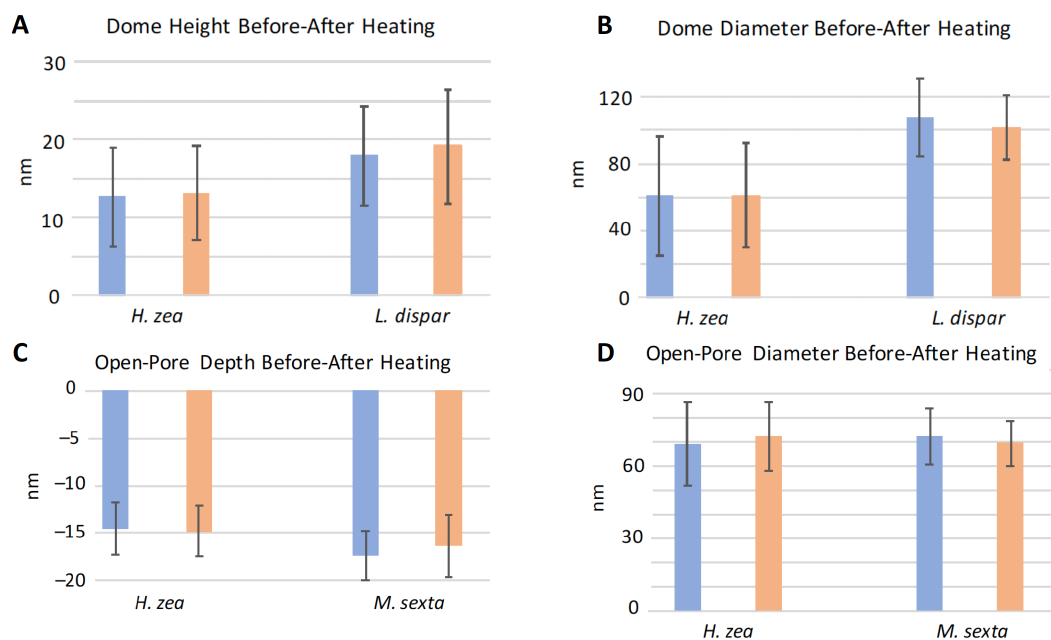
Figure 10. Effect of heating on mean heights, depths and diameters of domed-pore domes and open pores of Helicoverpa zea , Lymantria dispar and Manduca sexta trichoid sensilla. Blue histogram bars indicate measurements taken on sensilla at 23 °C. Orange bars indicate measurements taken on the same sensilla after heating to 50 °C. ( A , B ) N = 18 domes measured for H. zea and N = 10 for L. dispar . ( C , D ) N = 11 open pores measured for H. zea and N = 10 for M. sexta . Error bars denote standard deviation.